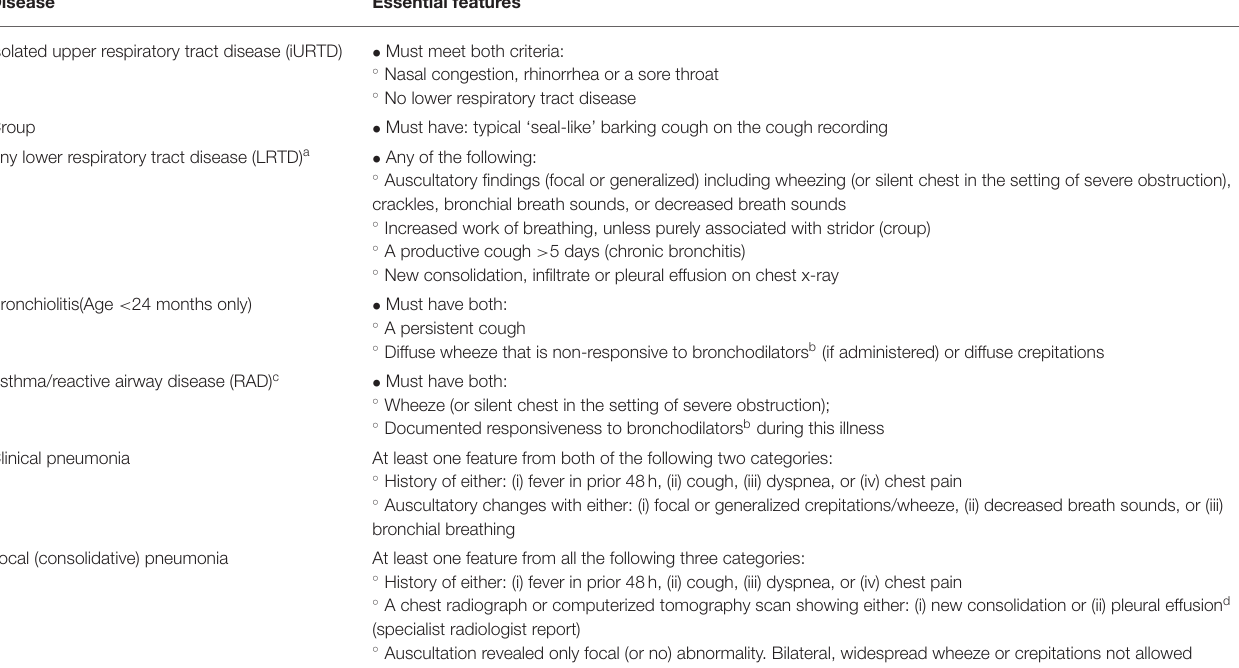
TABLE 1 | Definition of study